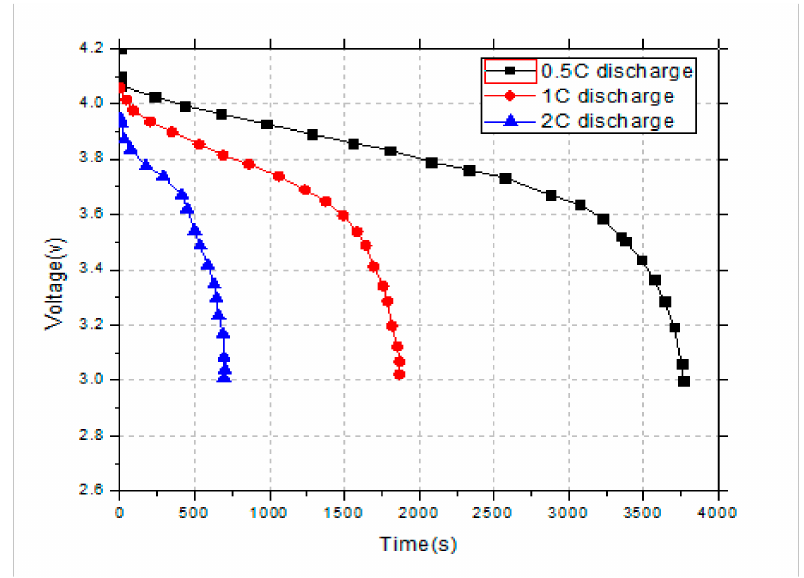
Figure 2. Discharge characteristics of LiFePO 4 battery at di ff erent ‘C’